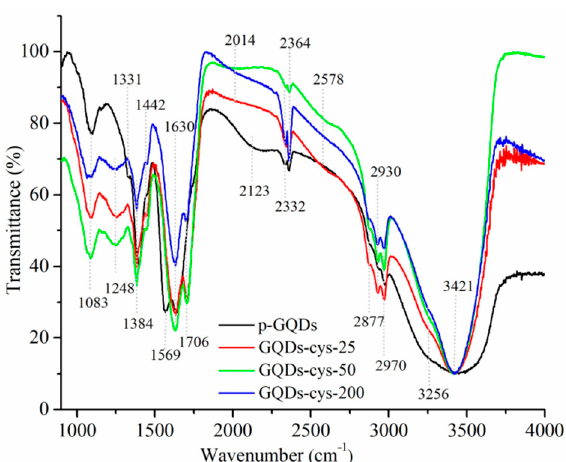
Figure 6. FTIR spectra of p-GQD (black), GQD-cys-25 (red), GQD-cys-50 (green) and GQD-cys-200 (blue).